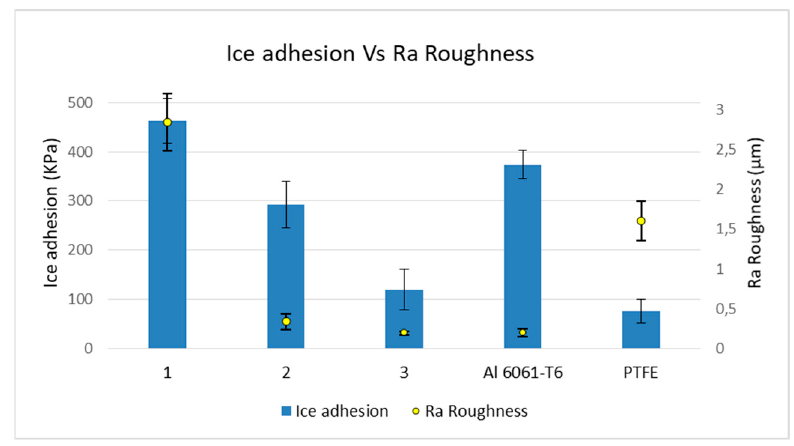
Figure 11. Ice adhesion results versus roughness of the coatings of study.